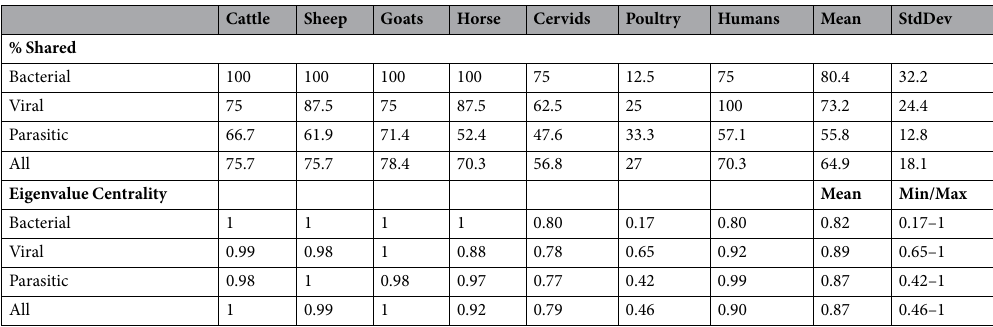
Table 3. All swine pathogens causing clinical and sub-clinical disease in livestock, poultry, cervids and